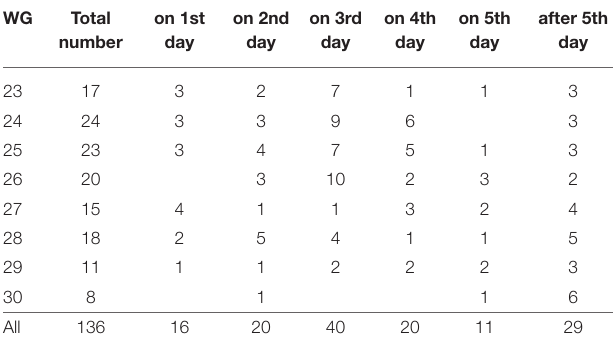
TABLE 2 | The day of IVH diagnosis (number of diagnosed infants for each gestational week). WG